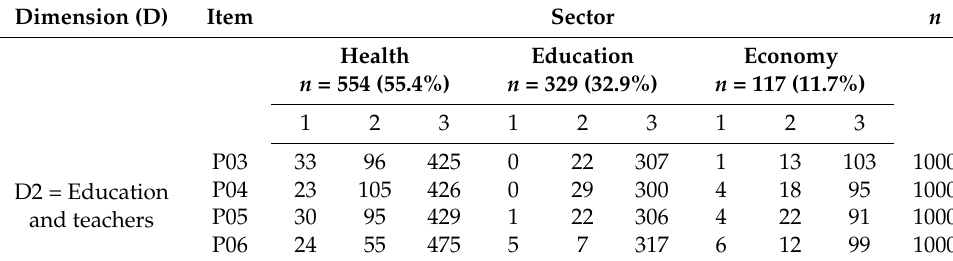
Table 7. Count by sector of the participating sample for dimension D2.